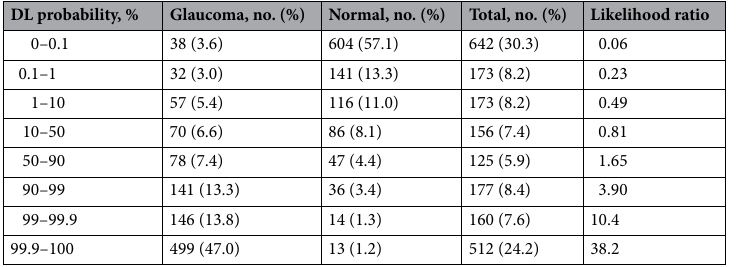
Table 4. Likelihood ratios for different intervals of Deep Learning probabilities of glaucoma. DL deep learning, No.